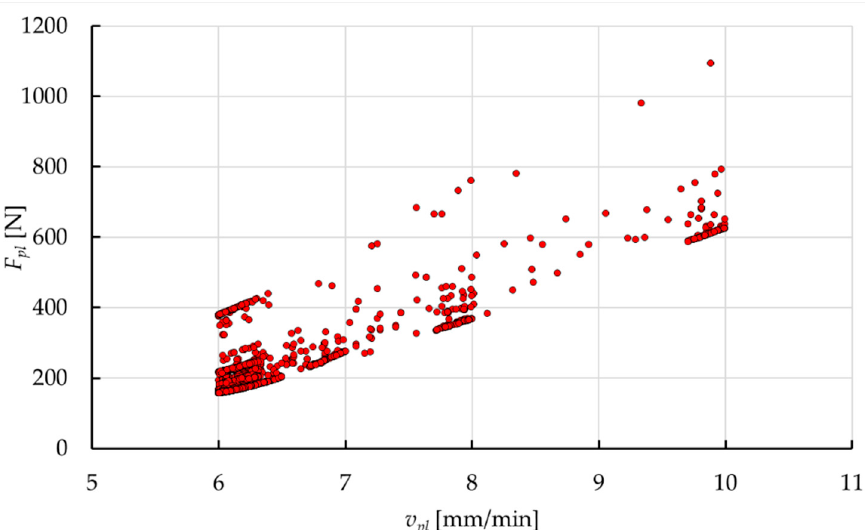
Figure 24. Exemplary map of the calculation points during the plasticization force calculations using the genetic algorithm for the belt with diameter of 18 mm and different plasticization velocity v pl .